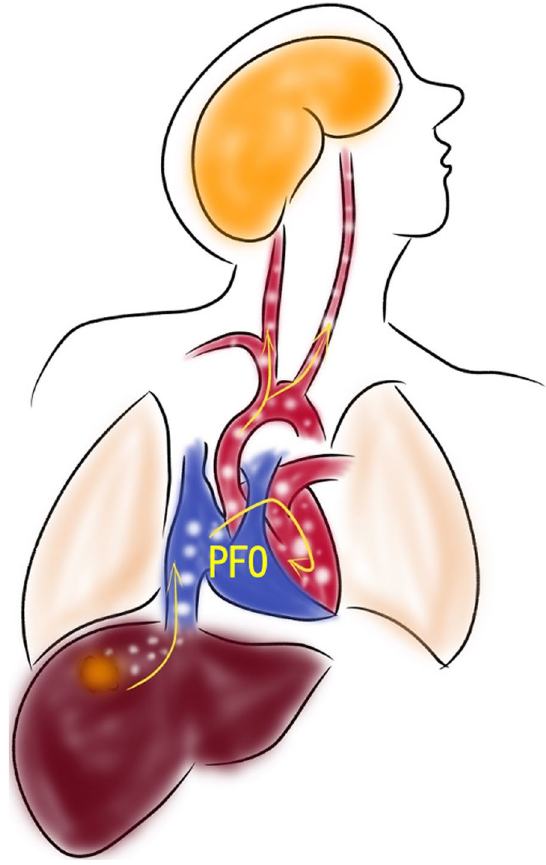
Fig. 8 Schema of patent foramen ovale causes a right-to-left shunt. The shunt was secondary to a CO 2 embolism, leading to cerebral